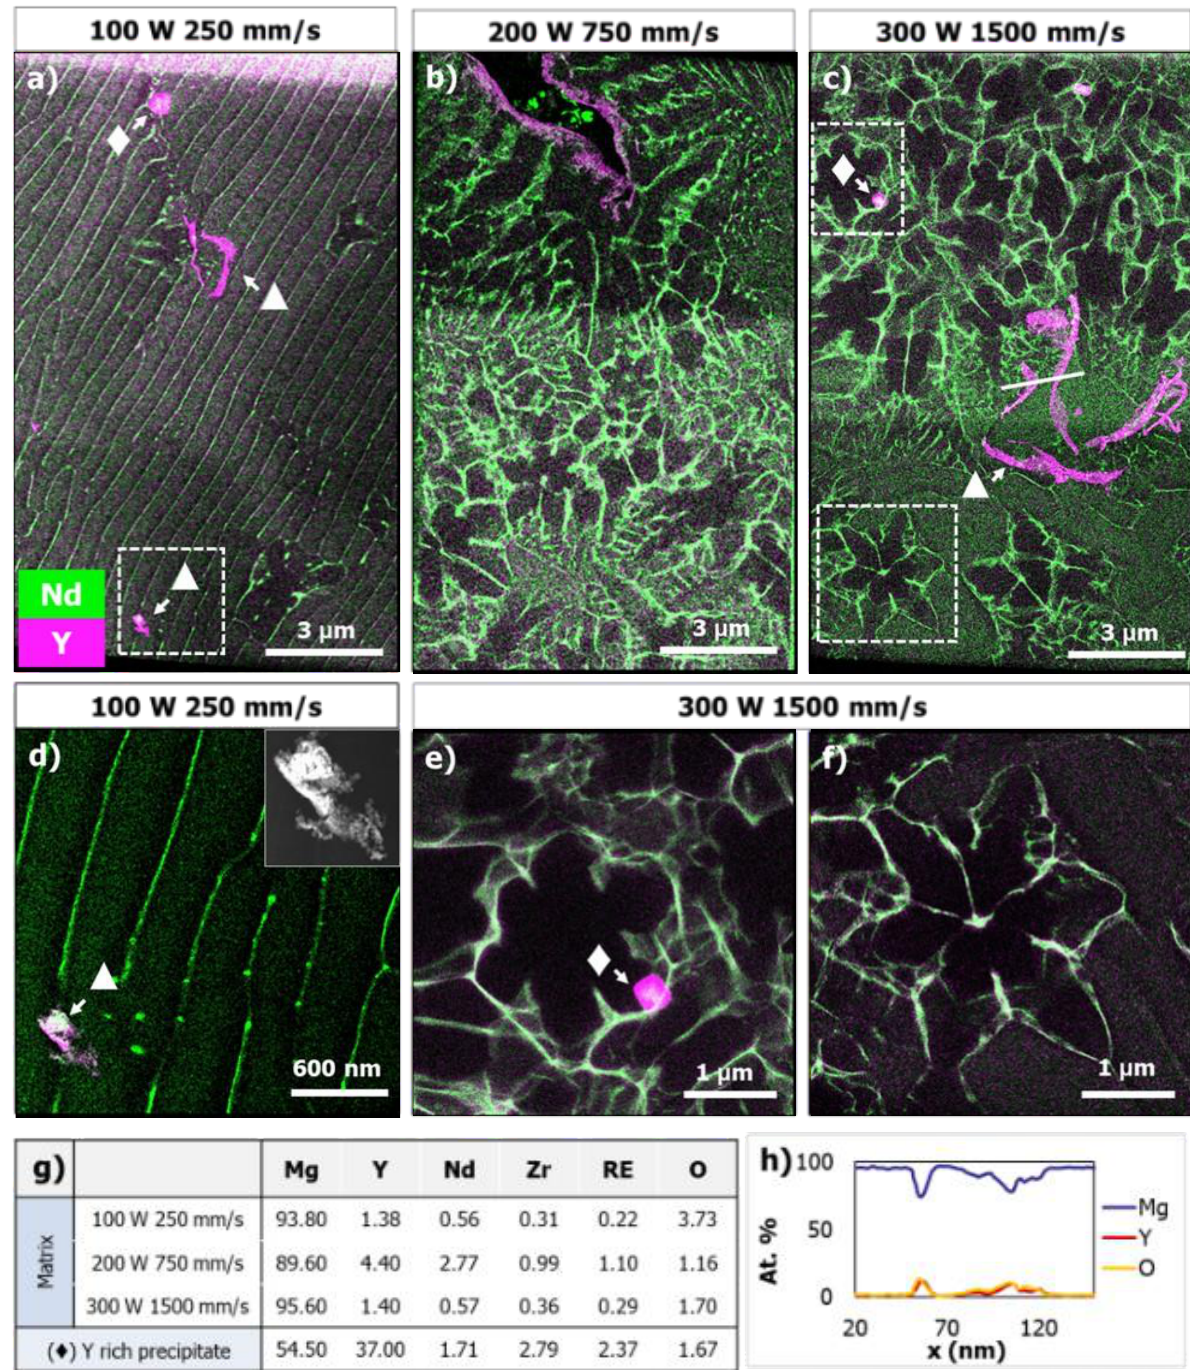
Figure 9. STEM EDS elemental maps in WE43 of three laser tracks with similar melt-pool geometries. Colorization of images shows the distributions of Nd and Y. ( a ) A 100 W, 250 mm/s sample showing a cellular structure; ( b ) 200 W, 750 mm/s sample showing a dendritic equiaxed structure; and ( c ) 300 W, 1500 mm/s sample showing a dendritic equiaxed structure. ( d ) Enlarged image from the highlighted box in (a) showing a cellular structure and Y-rich region; inset: magnified image of the feature denoted by ▲ . ( e ) Enlarged image of a hexagonal dendrite structure with secondary-phase particle ( ♦ ). ( f ) Higher-magnification image of a hexagonal dendrite showing the RE-rich center. ( g ) Composition (at. %) of the matrix in ( a – c ) and the average measured composition of the secondary-phase particles ( ♦ ). ( h ) Composition of line scan (white line in ( c )) across the powder-shell fragments showing the presence of both Y and O ( ▲ ).